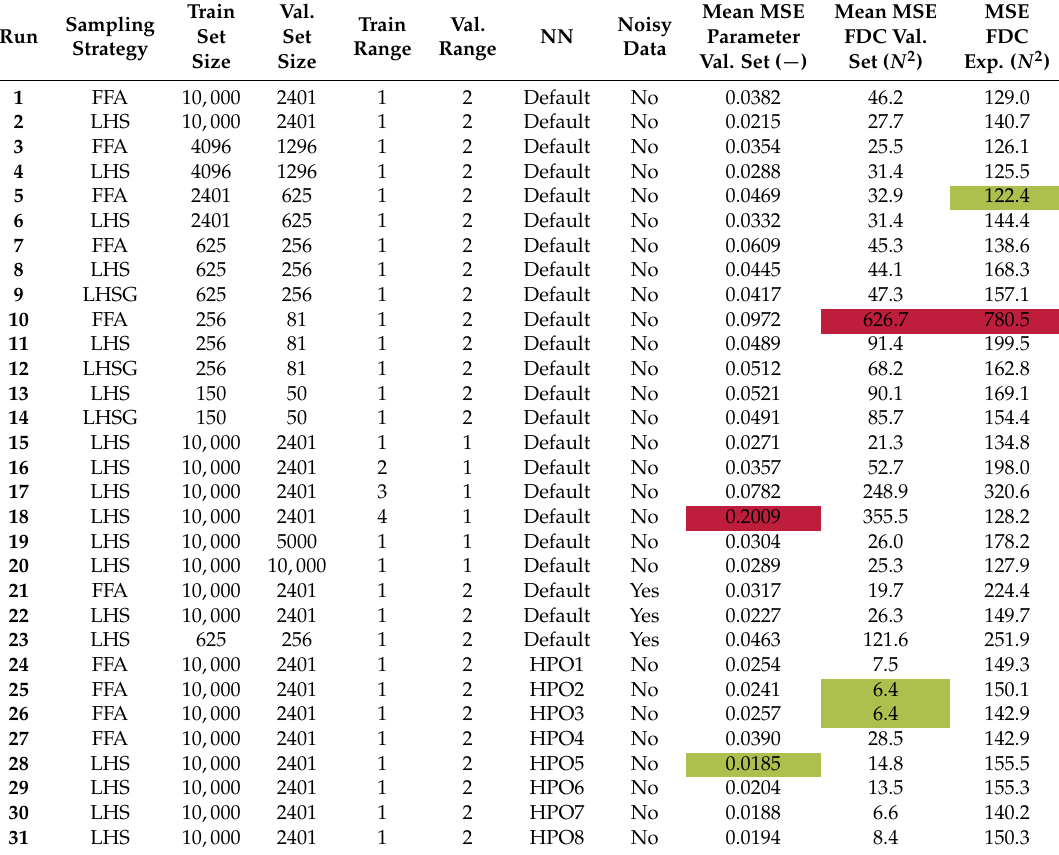
Table A1. Settings and results of NN-based material parameter identification Runs .